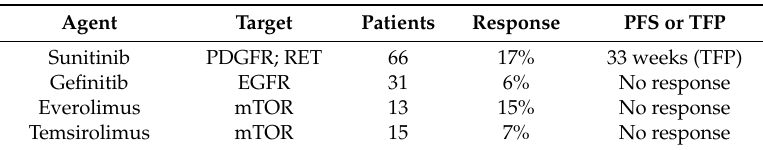
Table 3. Studies with new target therapies for neuroendocrine